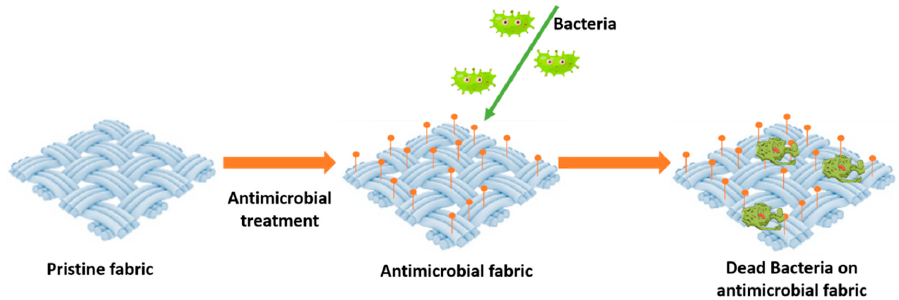
Figure 5. Mode of action of antimicrobial textiles.